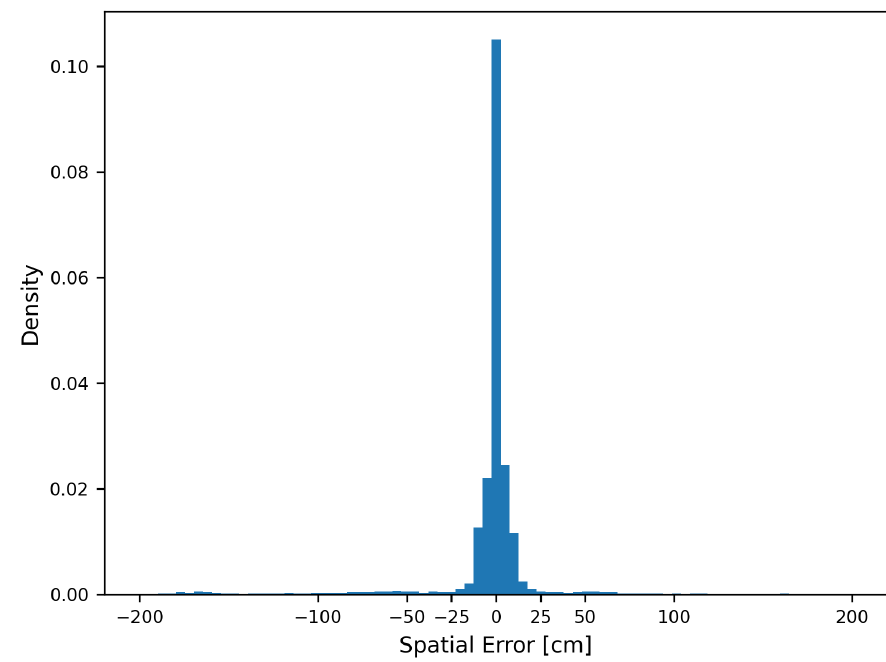
Figure 11. Differences between true and predicted axle positions for a threshold of 2 m.